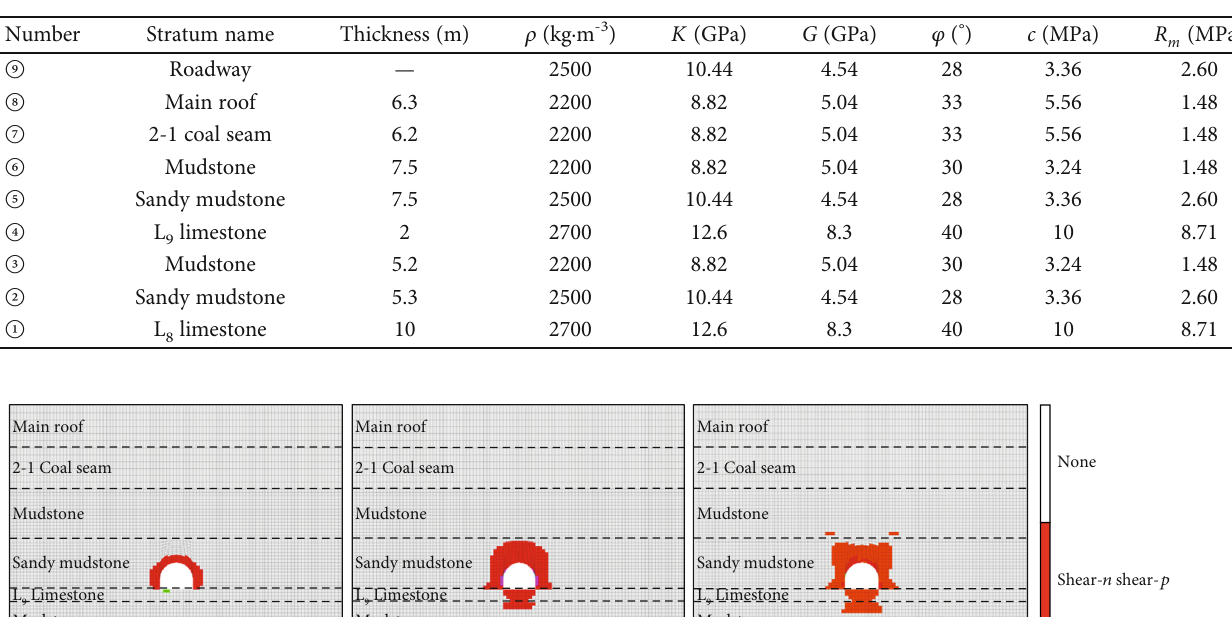
Table 1: Model layout and rock mechanics parameters.